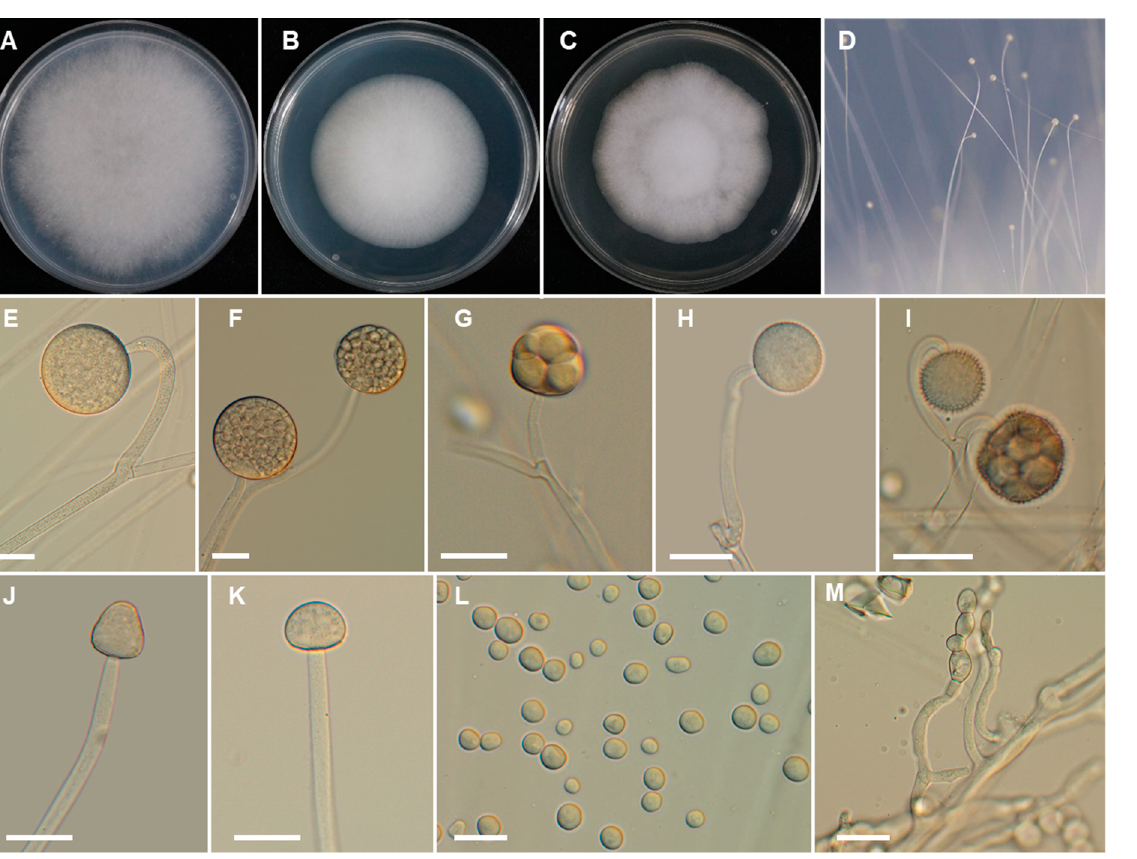
Figure 3. Morphology of Backusella chlamydospora . A , Colony on SMA. B , Colony on PDA. C , Colony on MEA. D , Sporangiophores forming sporangia. E , F , Sporangia. G , Multi-spored sporangiolum. H , Uni-spored sporangiolum. I , Uni- and multi-spored sporangiola borne on circinate branches. J , K , Columellae of different shapes. L , Sporangiospores. M , Chlamydospores. Scale bars = 20 μ m.